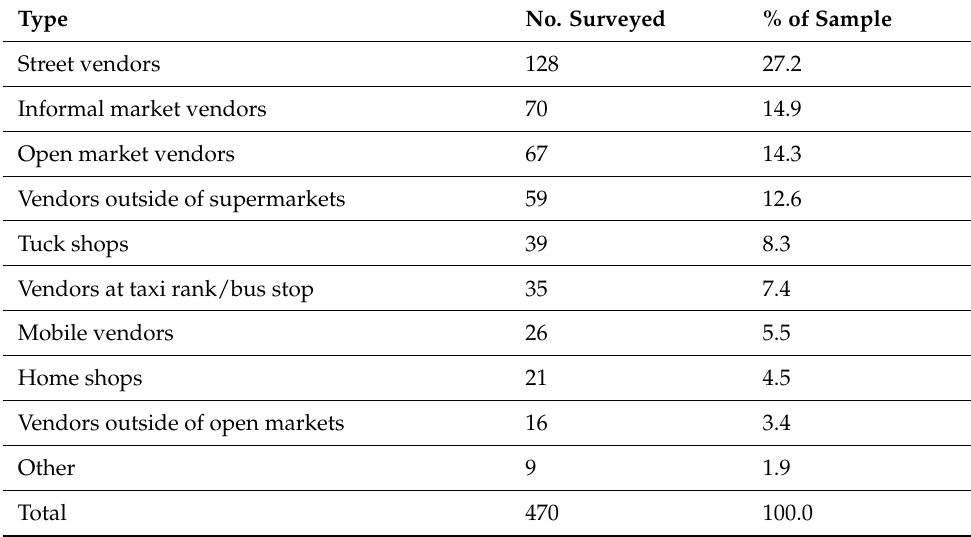
Table 3. Types of informal food enterprise in Windhoek,